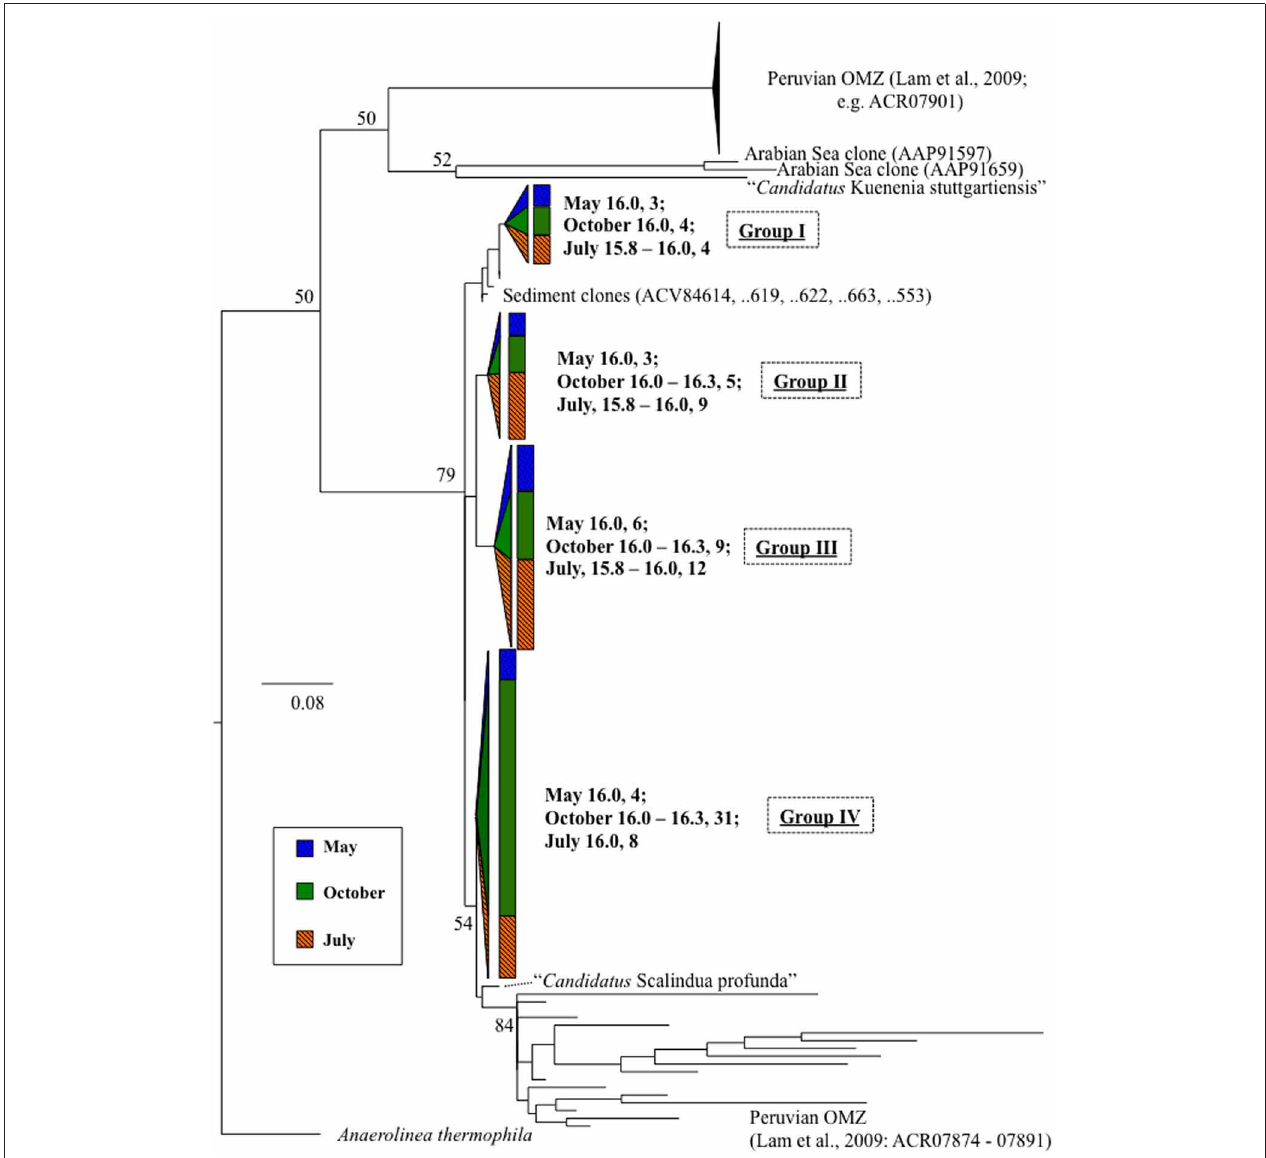
FIGURE 3 | Scalindua-type nirS expression, in bold, as detected with primers Scnir372F and Scnir845R (Lam et al., 2009). Numbers indicate density, followed by number of clones. References include cultured strains (in italics), and environmental clones. “ Candidatus Scalindua” is from van de Vossenberg et al. (2012). Tree was constructed from amino acid sequences